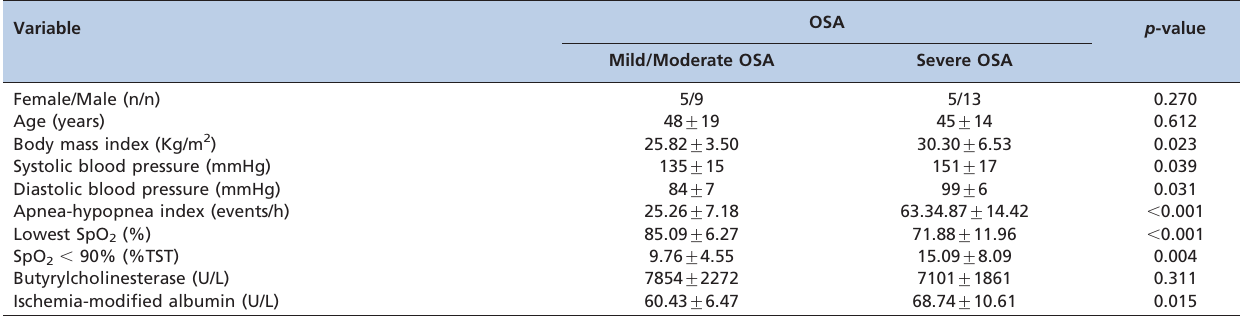
Table 2 - Demographic information and laboratory values for obstructive sleep apnea patients at admission (n= 32).